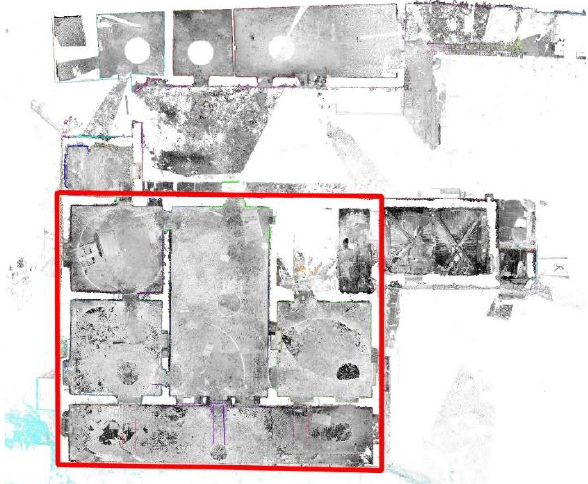
Figure 8. Planar view of the point cloud showing the first floor of the